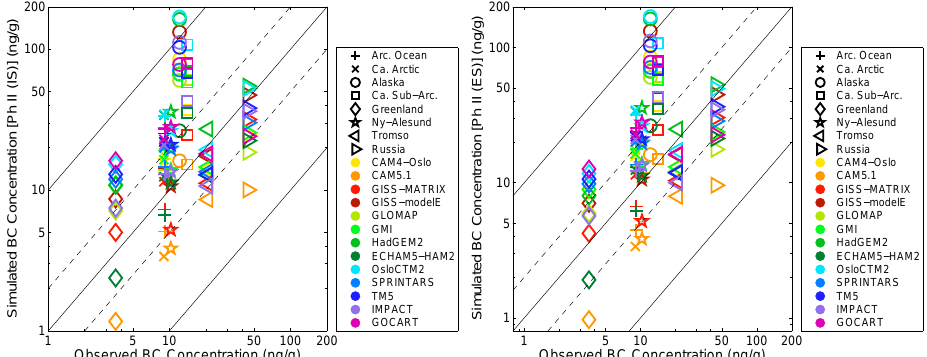
Fig. 2. Log-scale scatter plot of BC-in-snow concentrations simulated in different regions with phase I models applying inefficient meltwater scavenging (left panel) and efficient scavenging (right panel), compared with observations. The mean values for each region are averaged over grid cells matching the location, time, and depth of measurements.